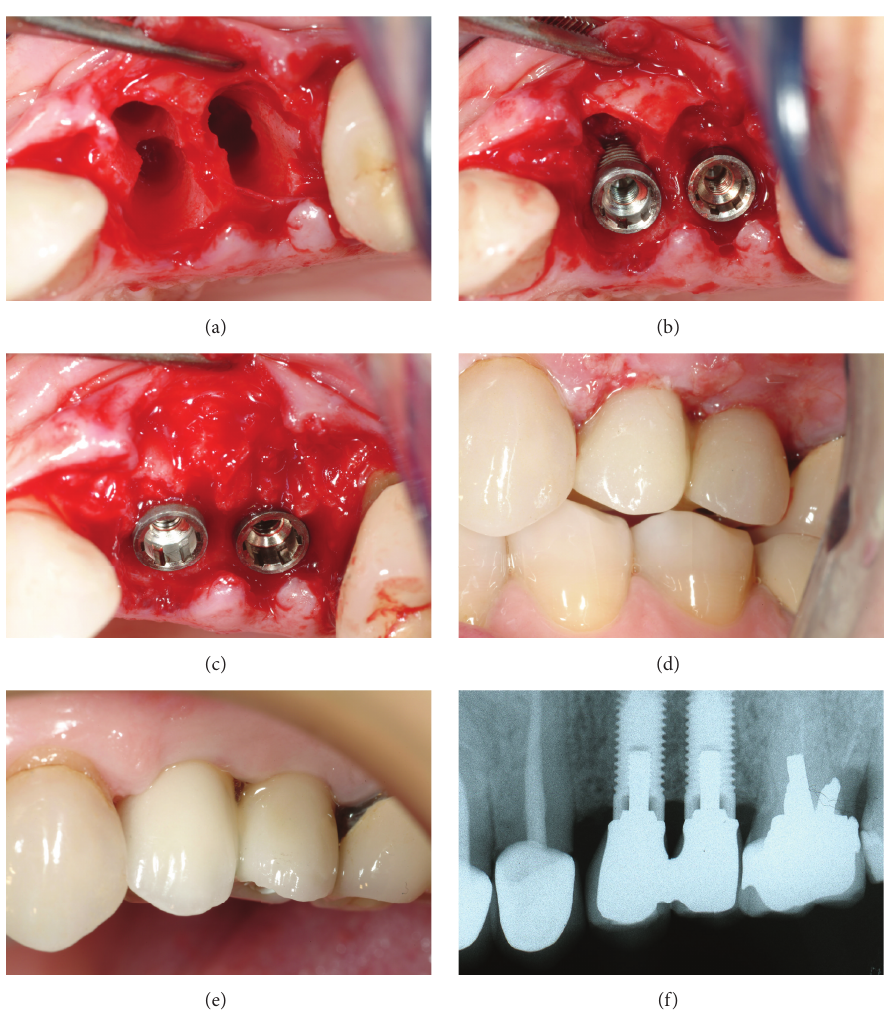
Figure 2: (a) Two adjacent extraction sockets in maxilla. (b) One bimodal and one proactive implant installed into fresh extraction sockets. (c) The bone defects were treated with autologous bone particles. (d) Temporary prosthesis without occlusal contacts. (e) Final restoration. (f) The radiograph after 3